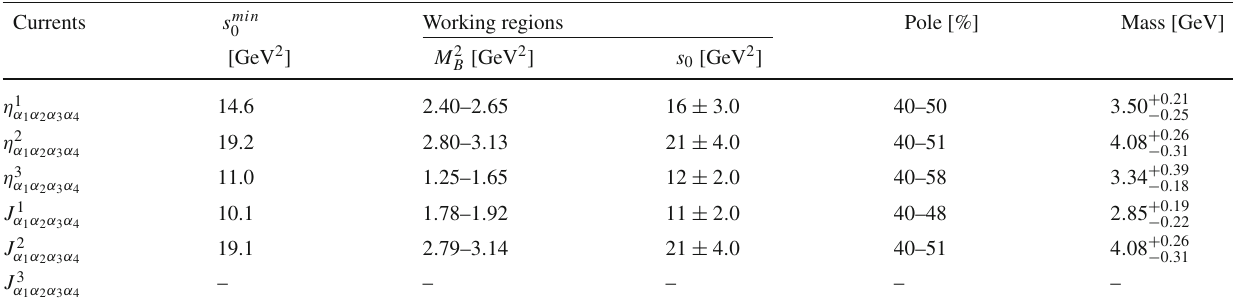
Table 1 QCD sum rule results for the fully-strange tetraquark states with the exotic quantum number J PC = 4 +− , extracted from the diquark– antidiquark currents η 1 , 2 , 3 α as well as their mixing currents J 1 , 2 , 3 α 1 α 2 α 3 α 4 1 α 2 α 3 α 4 Currents s min Working 0